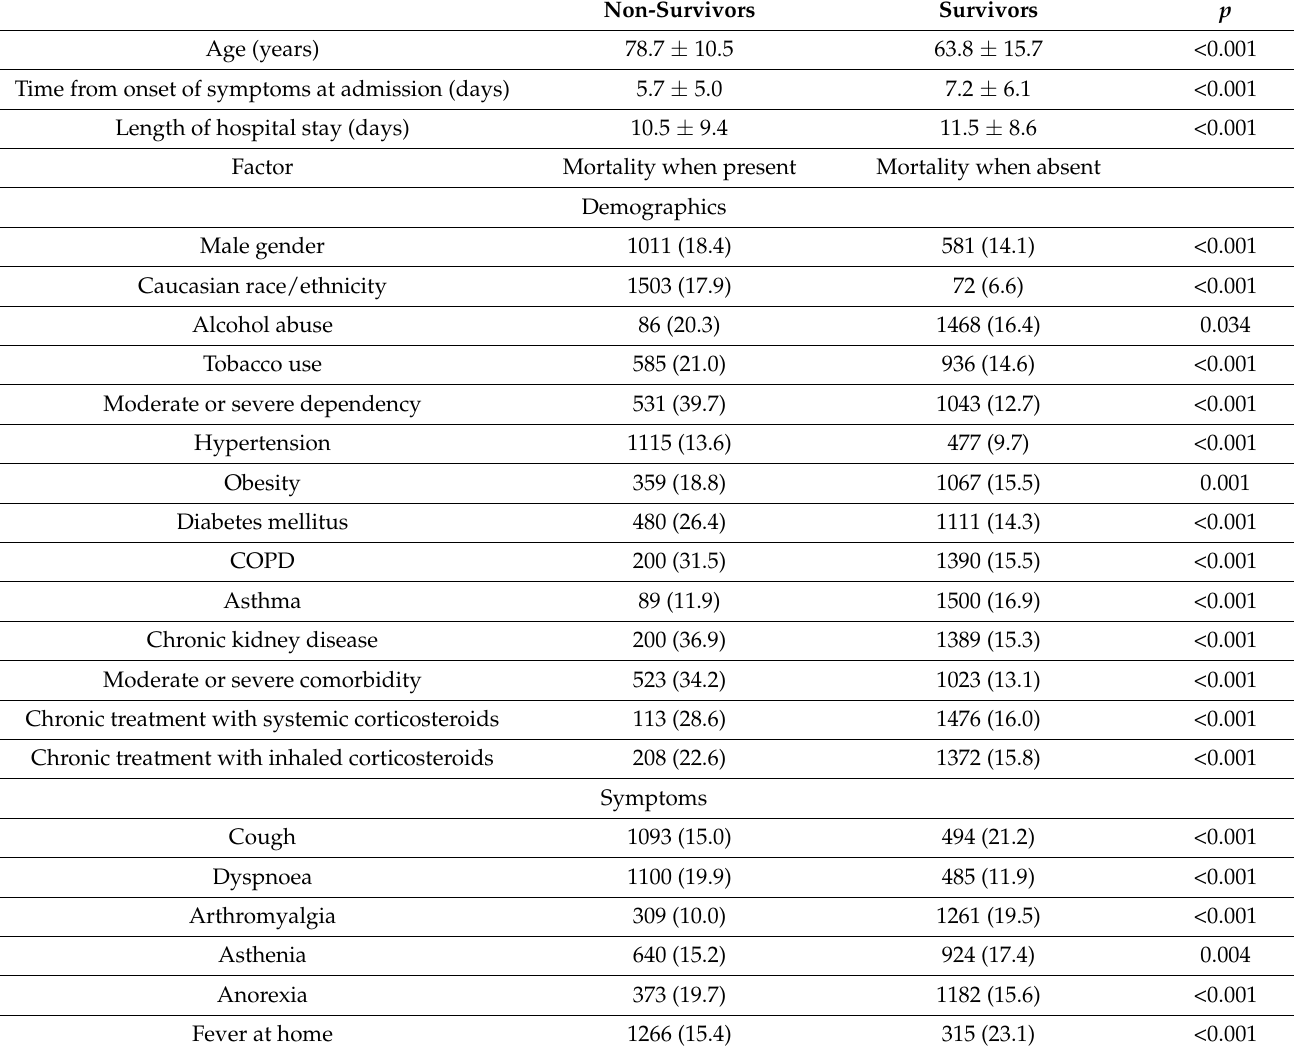
Table 3. Univariate analysis of mortality. Quantitative variables are expressed as mean ± SD in survivors and non-survivors. Categorical variables are expressed as mortality in N (%) for factor present and factor absent. For categorical variables with more than two categories, mortality is provided for each category as N